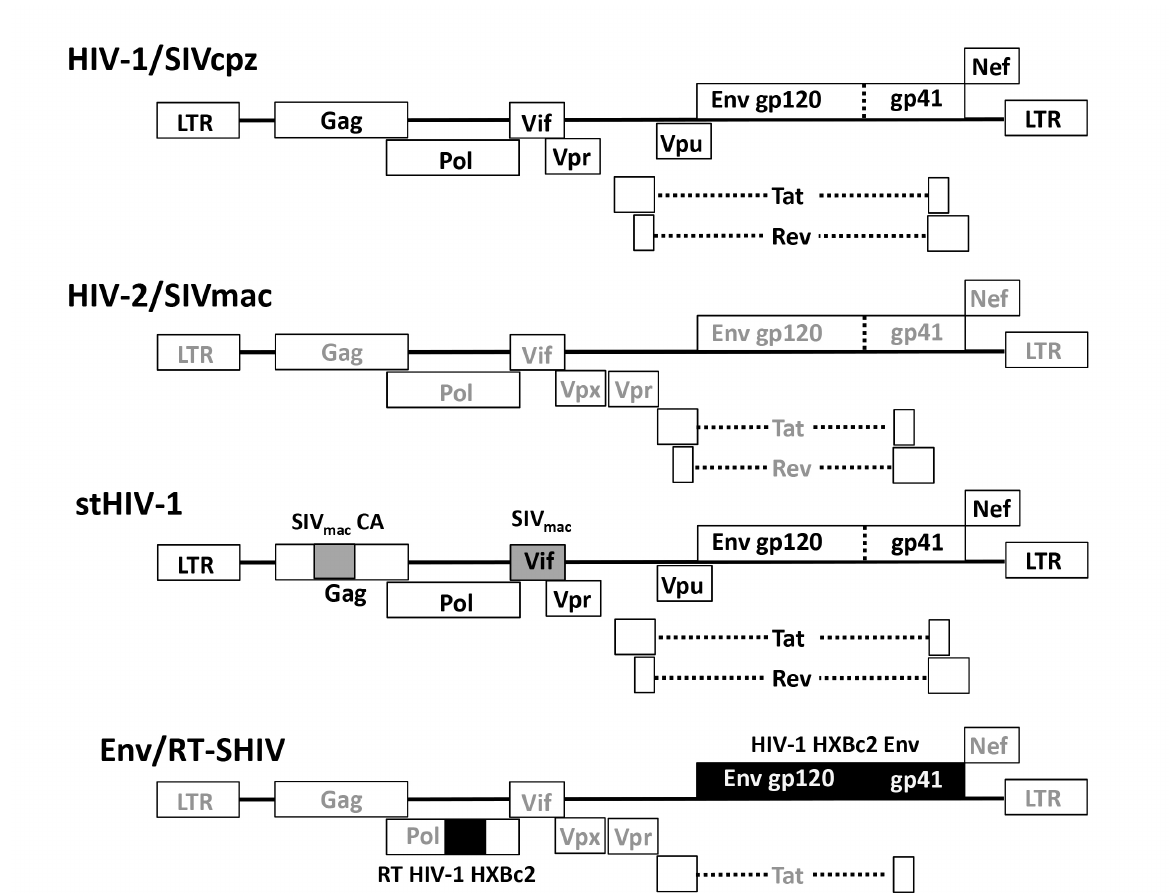
Figure 2. Schematic diagram of the genomic organization of HIV-1, HIV-2, SIV, stHIV-1 and SHIV vi- ral genomes. HIV-1/SIVcpz encodes the vpu gene but lacks the vpx gene. HIV-2/SIVmac encodes vpx but not vpu . The gag polyprotein encodes matrix (MA), capsid (CA), and nucleocapsid (NC). The pol genomic region encodes the viral enzymes protease (PR), reverse transcriptase (RT), and integrase (IN). Gray- and black-shaded boxes indicate SIV- and HIV-derived sequences, respectively. Abbreviations: SIV, simian immunodeficiency virus; stHIV-1, simian-tropic human immunodeficiency virus; SHIV, simian-human immunodeficiency virus; SIVcpz, chimpanzee-derived; SIVmac, macaque-derived; RT, reverse transcrip- tase; LTR, long-terminal repeat; env , envelope